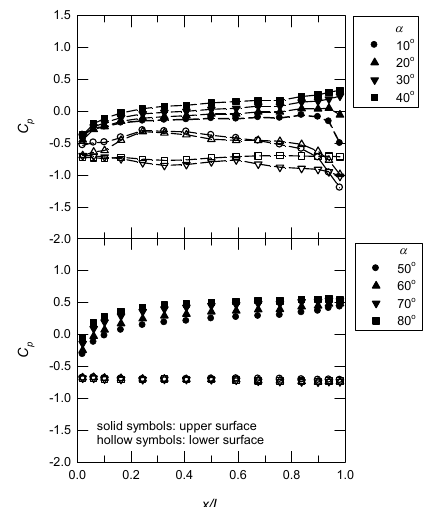
Figure 5. Mean longitudinal pressure distributions at y/W = 0.5; β = 45°.